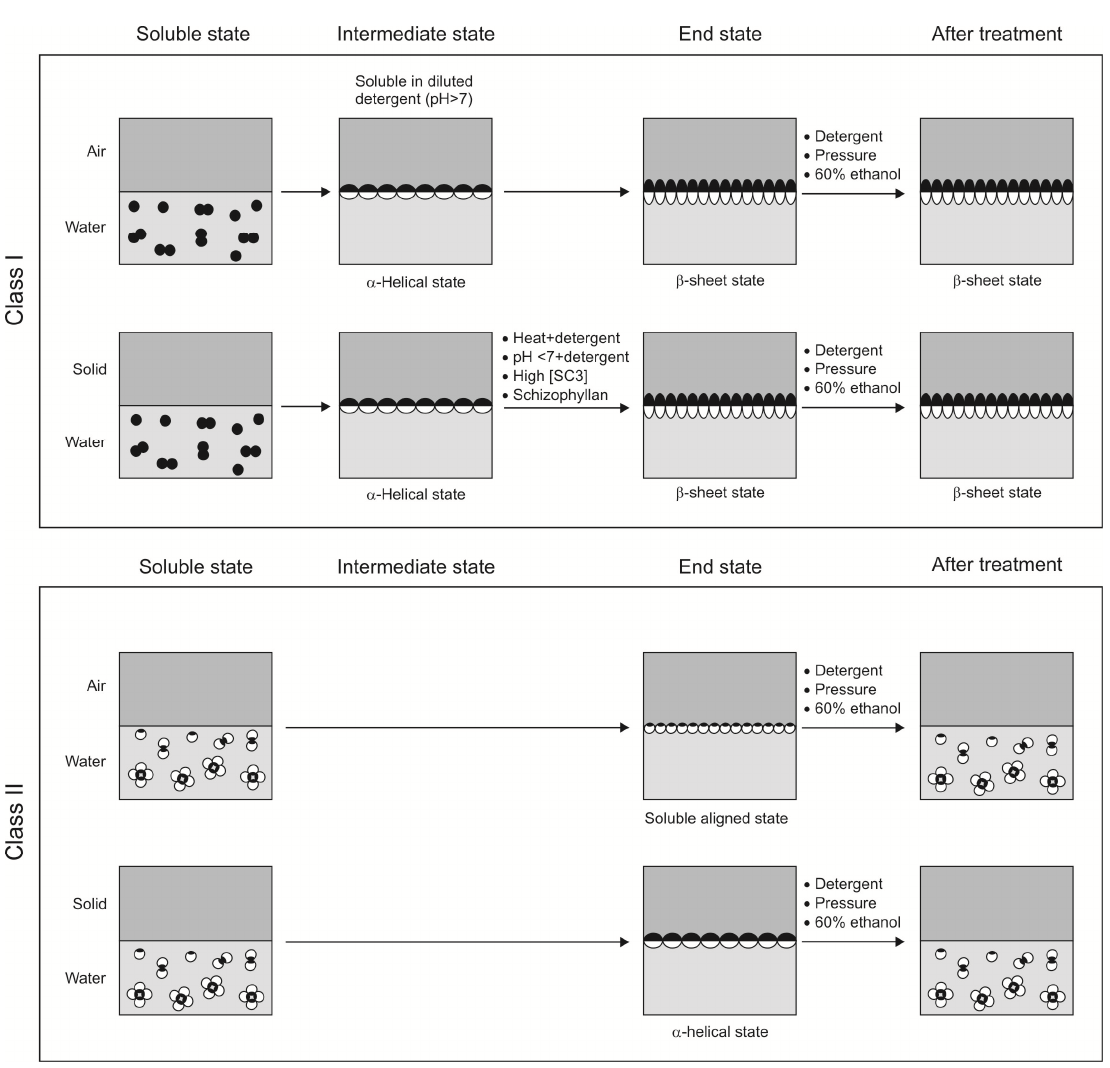
Figure 2. Model for assembly of class I and II hydrophobins at a hydrophilic-hydrophobic interface. At a water-air interface, class I hydrophobins (e.g., SC3; upper panel) spontaneously self-assemble via an α -helical intermediate state into a stable β -sheet end configuration. In contrast, upon contact with hydrophobic solids (e.g., Teflon) in water, SC3 is arrested in the intermediate α -helical configuration. The transition to the stable β -sheet end form is promoted by high protein concentration, presence of the polysaccharide schizophyllan (SPG) and the combination of heat or low pH and detergents. Class II hydrophobins (lower panel) do not assemble via an intermediate form. At the water-air interface, the conformation remains the same compared to the soluble state. The molecules orient themselves at the interface with the hydrophobic patch directed towards the air and the hydrophilic part directed to the water (soluble aligned state). On a solid-water interface, a conformational change into an α -helical form is observed. The end state of class I hydrophobins (upper panel) is very stable and cannot be dissociated by pressure, detergent or 60% ethanol. In contrast, the end form of class II hydrophobins (lower panel) readily dissolves under these